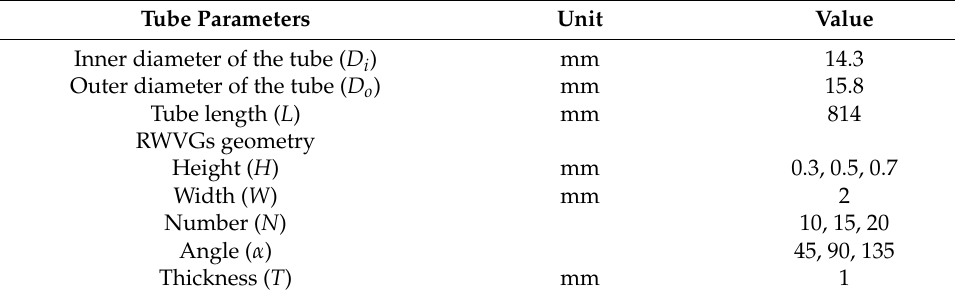
Table 1. Geometrical structures and parameters used during numerical studies. Tube Parameters Unit Inner diameter of the tube ( D i